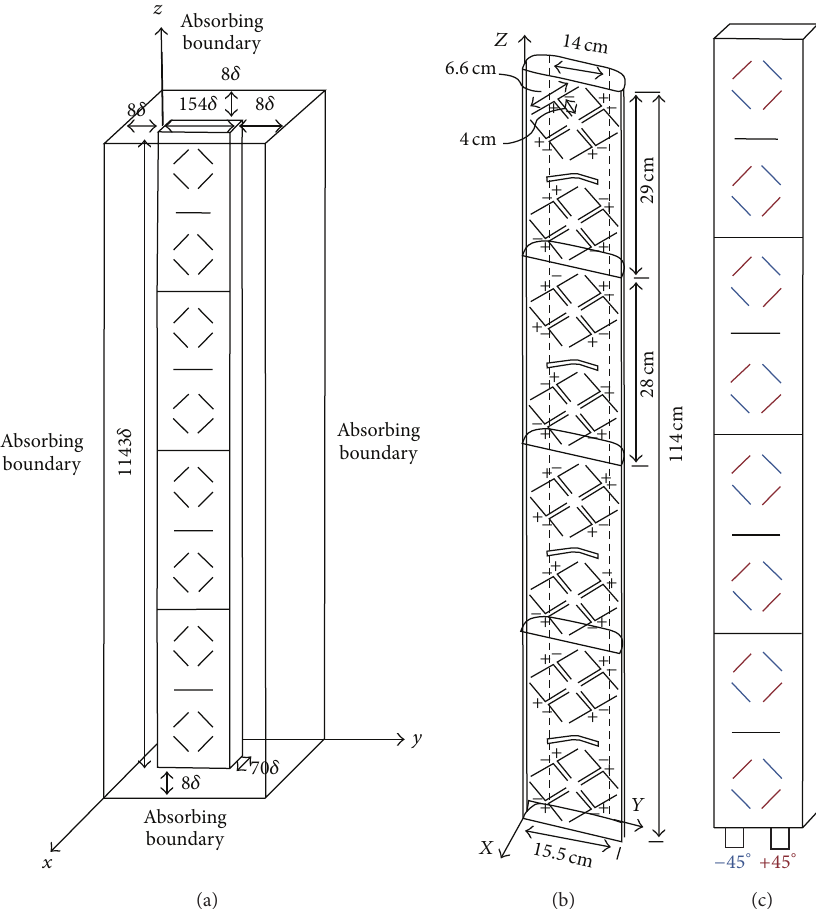
Figure 1: (a) FDTD model with 86 × 170 × 1159 = 16, 944, 580 cubic cells. The cell size is 1mm. (b) Relative locations of 32 radiators. (c) Illustration of two identical feeding lines excited by different phases of +45 ∘ (red line) and − 45 ∘ (blue